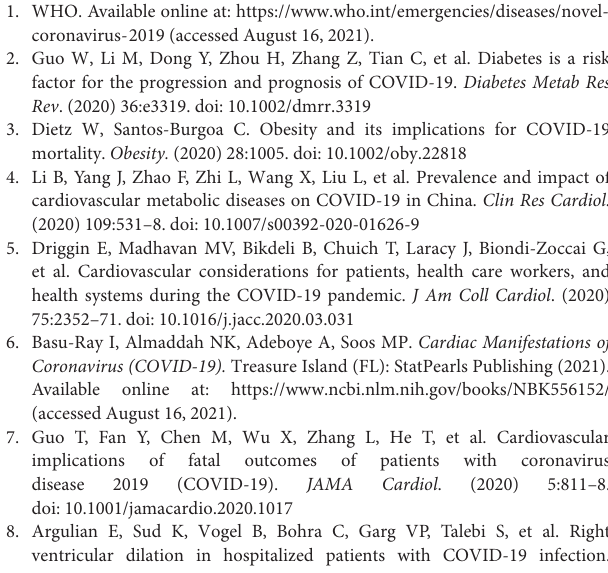
showing fibrosis (blue and purple), infiltration of immune cells (yellow arrow), accumulation of lipid droplets (red arrow), and enlarged nuclei (green arrowhead) (40X magnified; bar-50 µ m). Supplementary Figure 3 | Alterations in cardiomyocyte size during CoV2/T. cruzi infection and coinfection in male and female mice: (A) H&E sections showing the average cell size in left ventricles (cardiomyocytes - green arrowhead; endothelial cells - yellow arrowhead; macro-lipid droplets - black arrowhead; and immune cells - red arrowhead) (40X magnified; bar-50 µ m). (B) Masson trichrome images (gray scale) of right ventricles showing changes in extracellular collagen layer (white) and thickness of intercellular collagen network during infection and coinfection (40X magnified; bar-50 µ m). (C) Illustration of cardiomyocyte hypertrophy determination by measuring cardiomyocyte length (Dmaj) and diameter (Dmin) and intercellular collagen thickness using histological sections (Masson trichrome) of the hearts. The data are presented as Supplementary Table 1A . Supplementary Figure 4 | Changes in the levels of ACE2 and metabolic signaling markers (Western blot analysis) in the heart/lungs are compared between male and female mice during CoV2/T. cruzi infections and coinfection. Fold changes in the protein levels were normalized to GDI and are represented as a dot plot. The error bars represent standard error of the mean. ∗ P < 0.05, ∗∗ P < 0.01, ∗∗∗ P < 0.001 and ∗∗∗∗ P < 0.0001compared between males and females in each group. Supplementary Table 1A | Cardiomyocyte volume by histology. Cardiomyocyte length and width were measured ( n = 40 cells/sex/group) on microscopic images of the cardiac histology sections (right ventricles) and the volume was calculated as described in Methods. The significance p -value for differences in volume was calculated by t -test comparing each group to sex matched uninfected mice and is denoted by “ ∗ ” ( ∗ p ≤ 0.05, ∗∗ p ≤ 0.01 and ∗∗∗ p ≤ 0.001). Supplementary Table 1B | Morphometric analysis of the hearts of CoV2/T. cruzi infected and coinfected male and female mice. The thickness of the right ventricle wall (RVW), left ventricle wall (LVW) and intra-septal wall (Septal -W) was measured as mentioned in materials and methods and is presented in mm. The significance p-value for differences in wall thickness was calculated by t-test comparing each group to sex matched uninfected mice and is denoted by “ ∗ ” ( ∗ p ≤ 0.05, ∗∗ p ≤ 0.01 and ∗∗∗ p ≤ 0.001). The significance p-value for differences in wall thickness between coinfected and sex matched T. cruzi infected mice is denoted by “#” (# p ≤